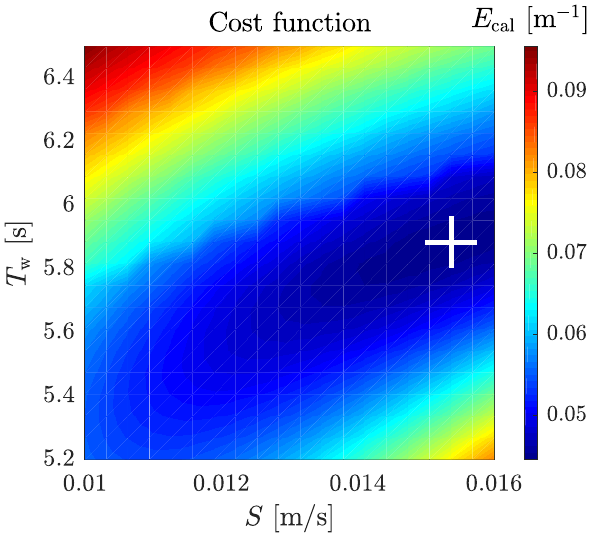
Figure 5. Cost function E cal in the neighborhood of the local minimum. The calibration parameters at the local minimum, denoted with the white cross, are S = 0.0154m/s and T w = 5.88s. Table 2. Location-dependent quantities for the 35 calibration † locations: model parameters, and ob- served vs. modeled sand wave characteristics after